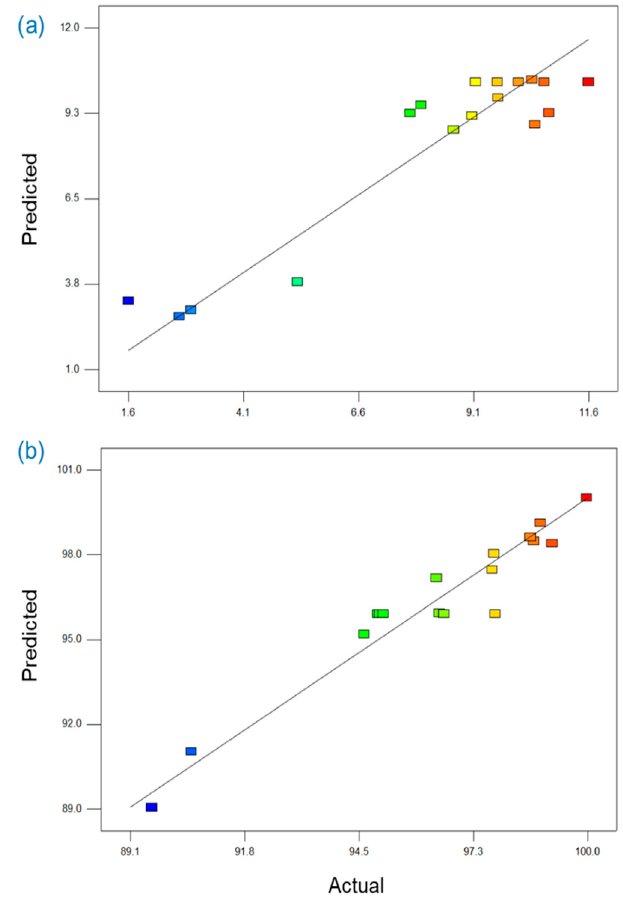
Figure 10. Plot of predicted values versus actual values for ( a ) permeate flux (L/m 2 · h) and ( b ) ammonium rejection (%). Table 4. Summary of ANOVA for response surface quadratic model of permeate flux and ammonium rejection. Underline indicates that p -value is less than